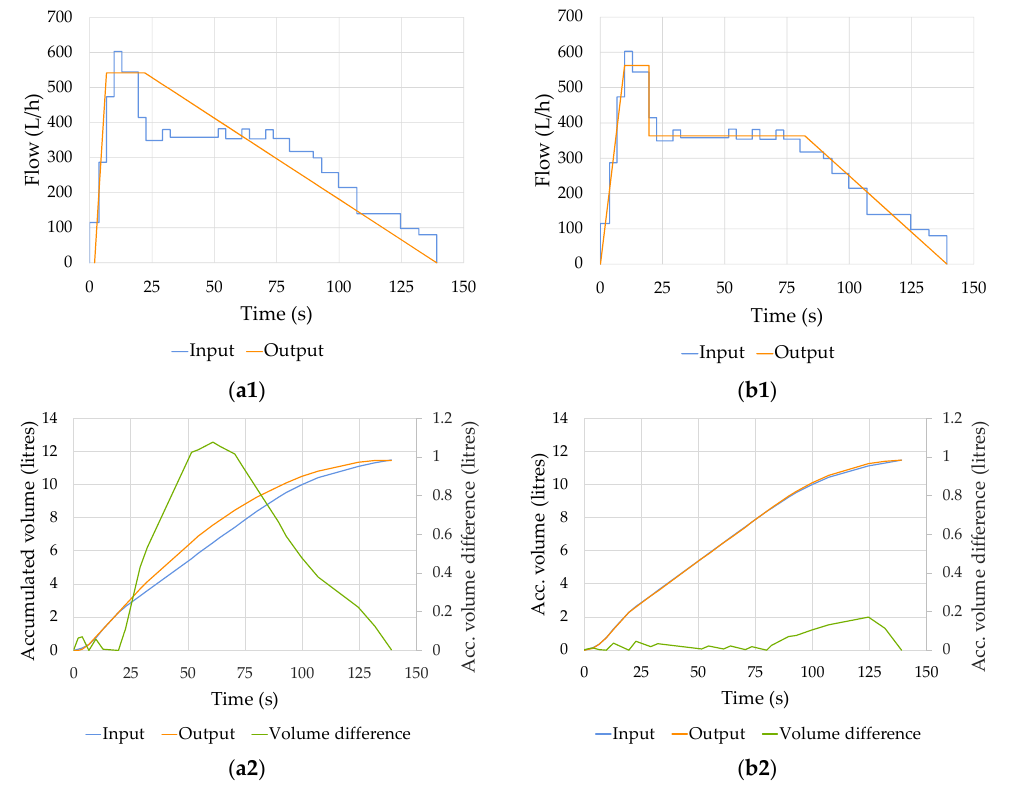
Figure 3. Comparison of raw flow traces vs filtered. ( a1 , a2 ) after Filter ‐ A and ( b1 , b2 ) after Filter ‐ B .